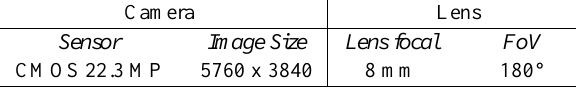
Table 3. Essential camera and lens specifications of the fisheye dataset